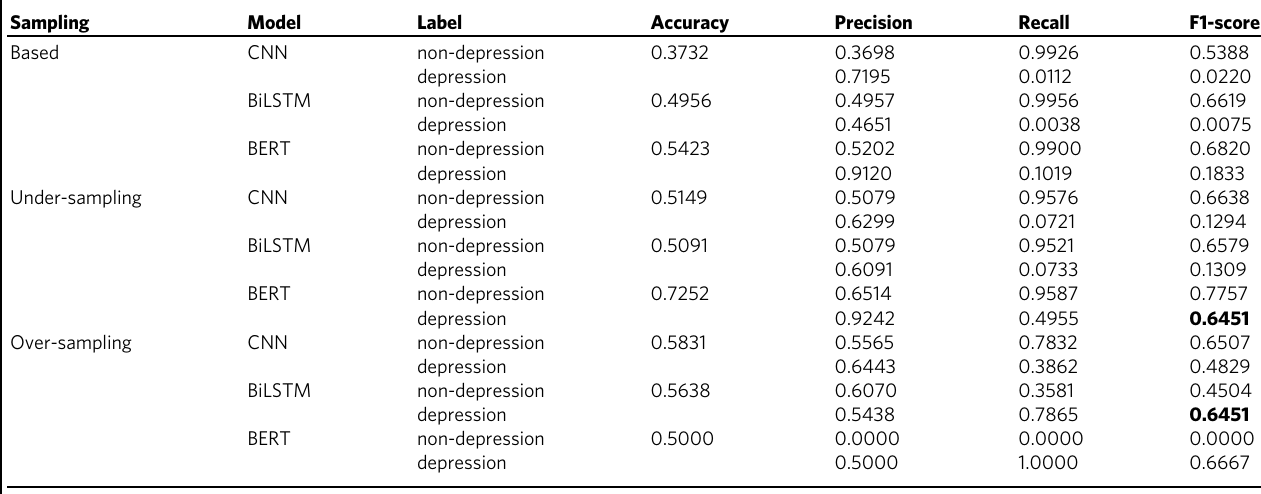
Bold values represent the greatest